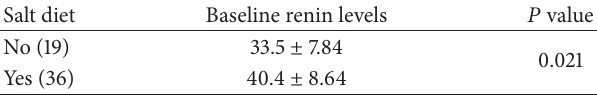
Table 6: Difference of renin levels based on salt intake. Salt diet